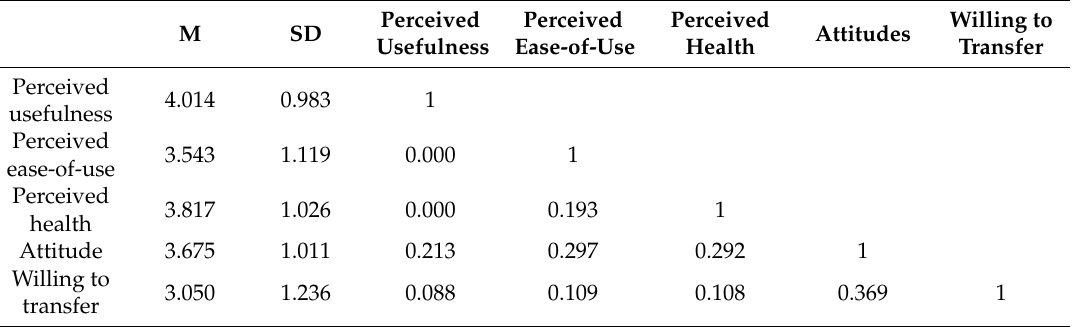
Table 3. Means, standard deviation, and